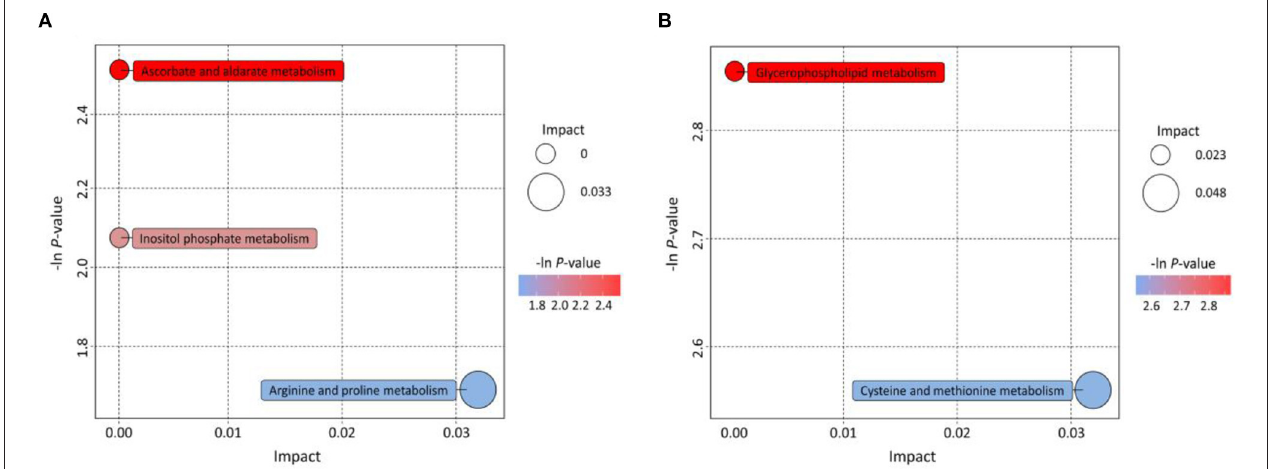
FIGURE 6 | KEGG annotations and enrichment of differentially expressed metabolites of each pairwise comparison of peach. (A) PG vs. SP; (B) PG vs. LT. Bubbles represent metabolic pathways, and the size and horizontal coordinate of the bubble represent the influence factor in the pathway. The larger the bubble size, the greater the impact factor. The longitudinal coordinate and the color of the bubble represent the P -value of enrichment analysis. The deeper the color and the smaller the P -value represent more significant enrichment degree.